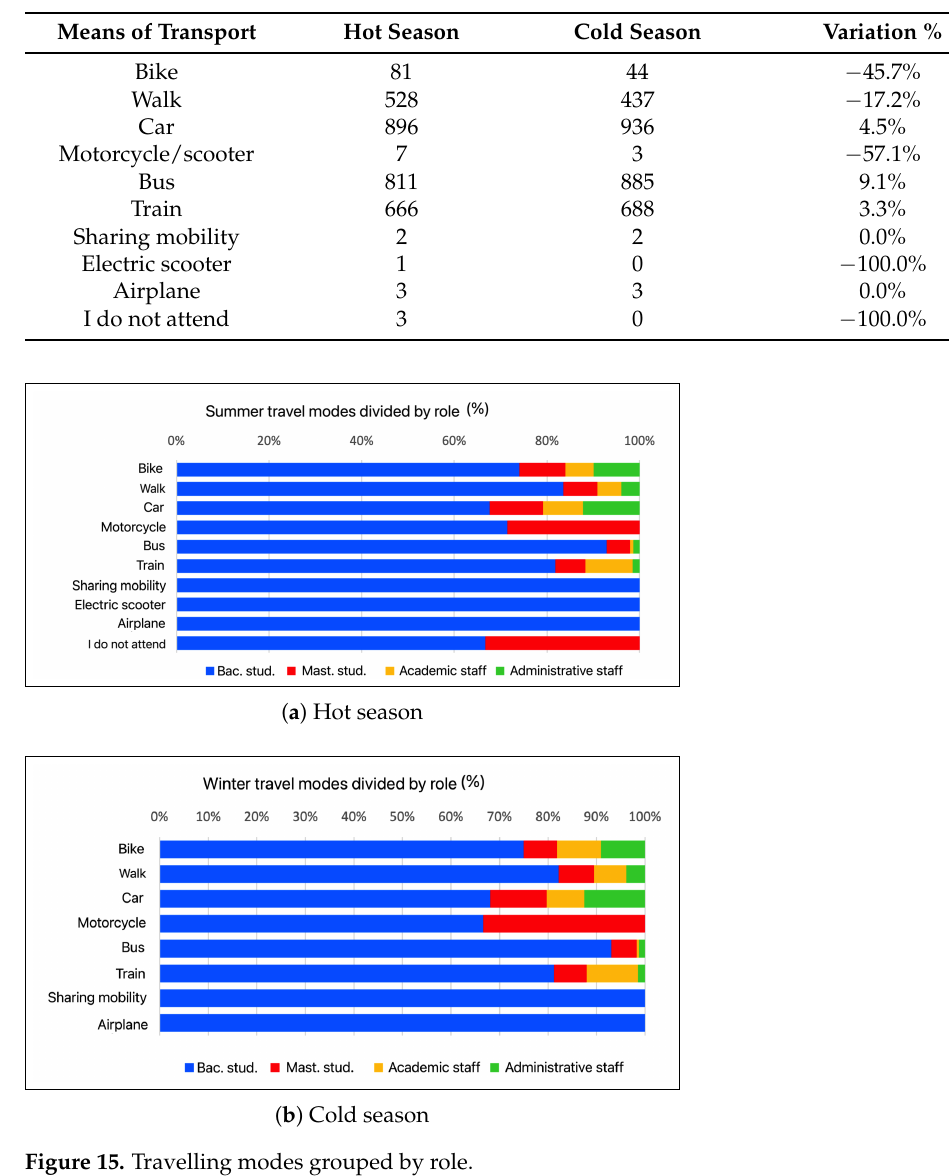
Table 5. Percentage variation in the use of different means of transport.